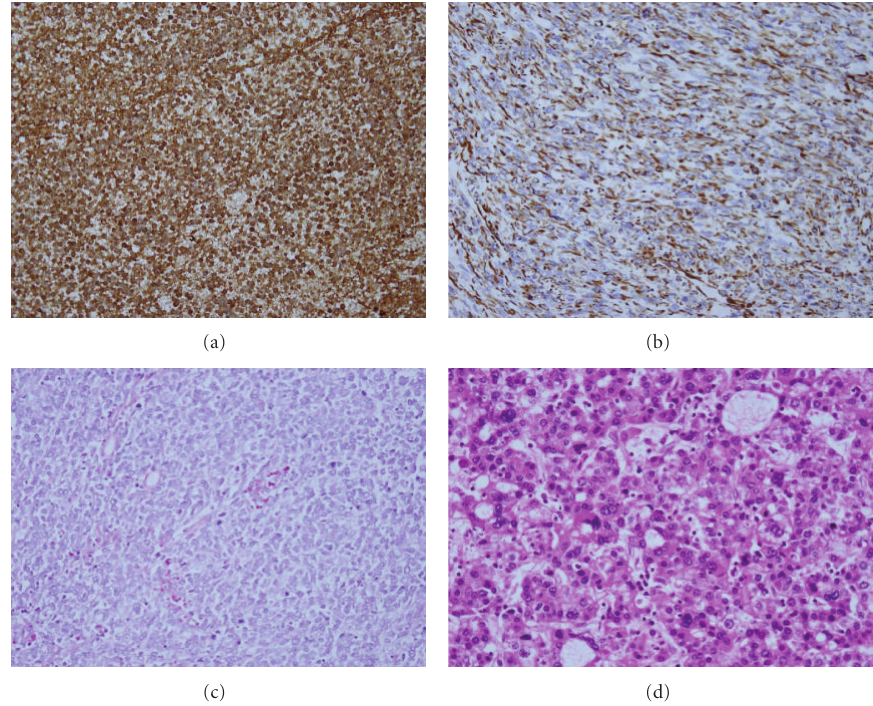
Figure 3: (a) Alpha 1 -antitrypsin immunohistochemistry di ff usely staining tumour cells ( × 200). (b) Vimentin immunohistochemistry staining tumour cells ( × 200). (c) PAS-positive, diastase-resistant intratumoral cytoplasmic and extracellular eosinophilic globules ( × 200). (d) Malignant hepatoid tumour nodule within the tumour (hematoxylin and eosin, ×